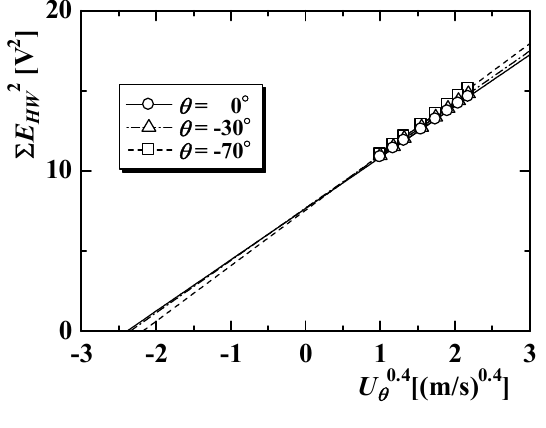
Fig. 7 Relations of 2